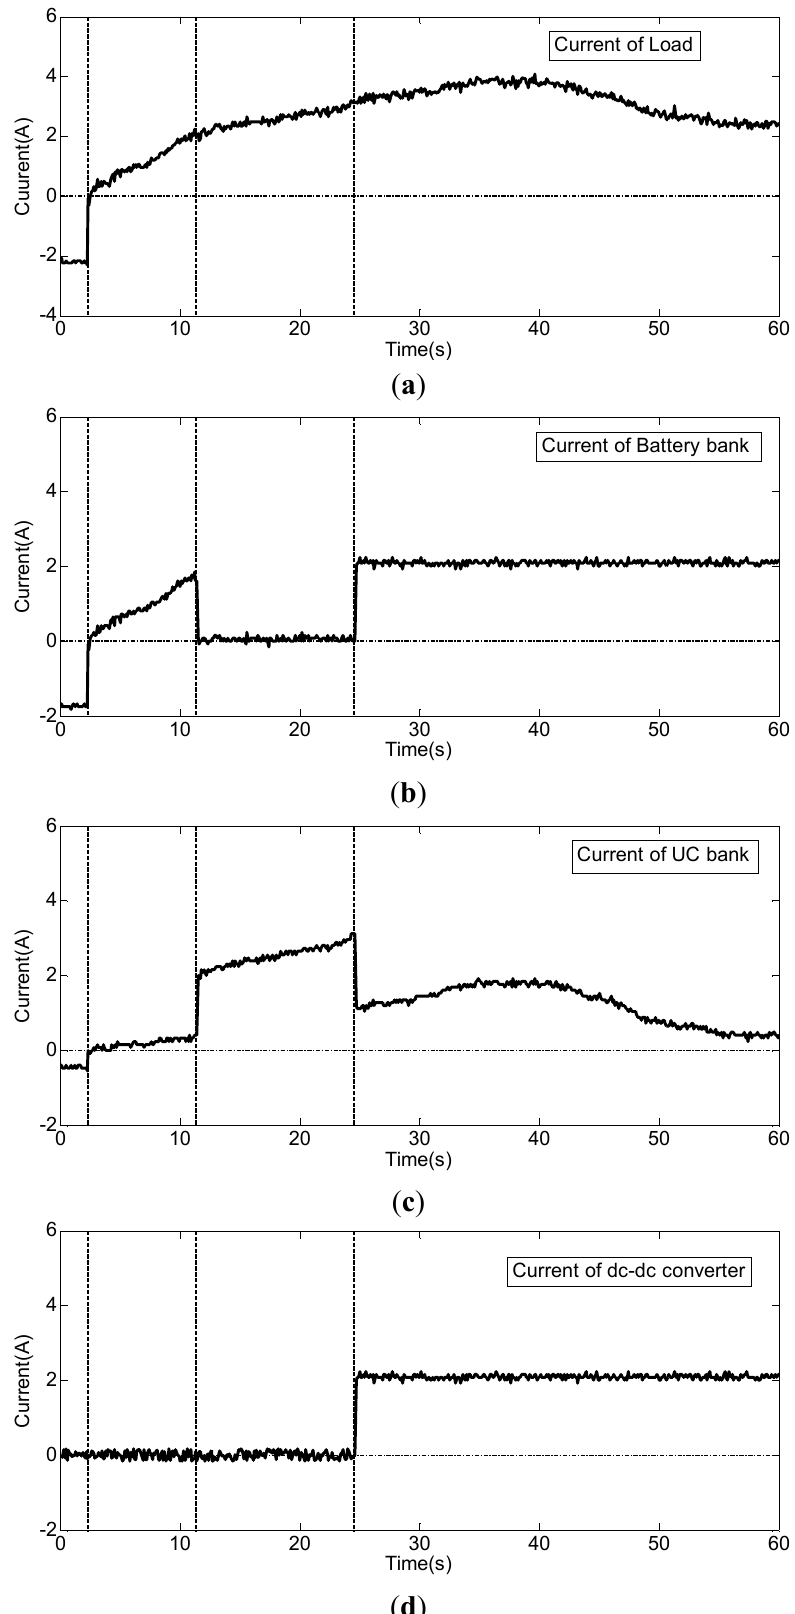
Figure 19. HESS charging with a variable load current. ( a ) load current; ( b ) battery bank current; ( c ) UC bank current; ( d ) bi-directional DC-DC converter current; ( e ) states of S1 and S2; ( f ) voltage of the battery bank and UC